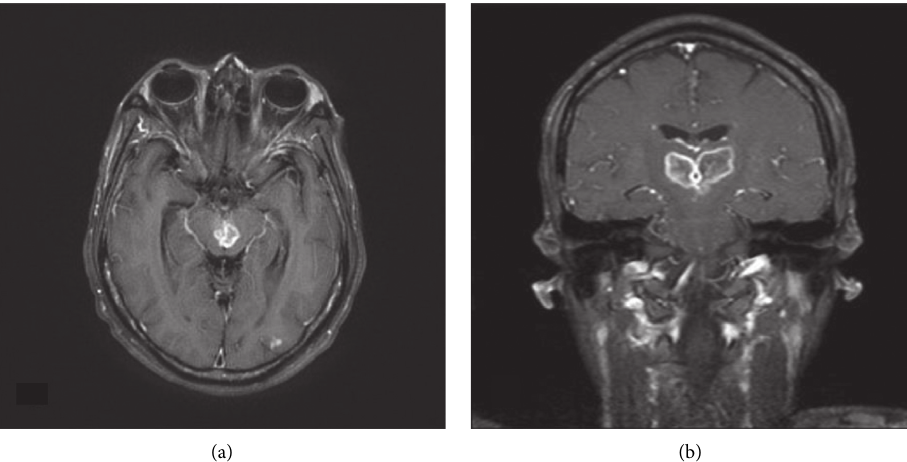
Figure 5: Postcontrast T1 MR images demonstrate vivid contrast enhancement involving the midbrain: (a) axial image and posterior thalami; (b) coronal